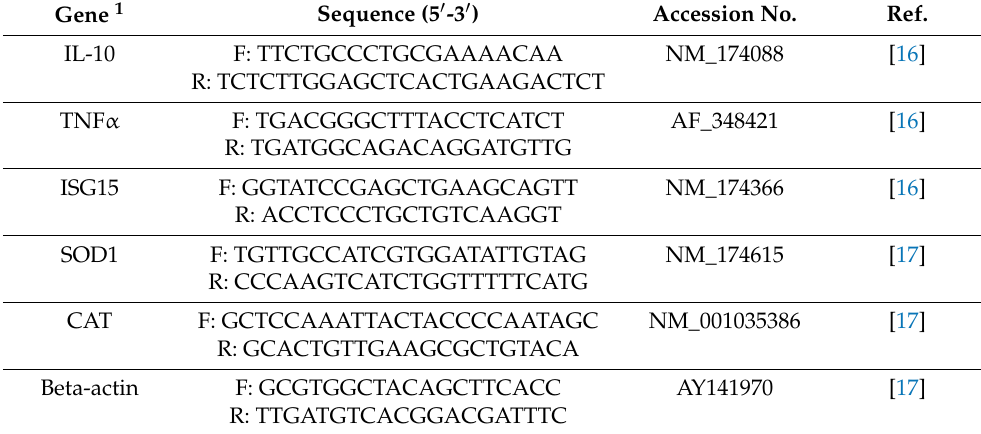
Table 1. Specific primers used in the